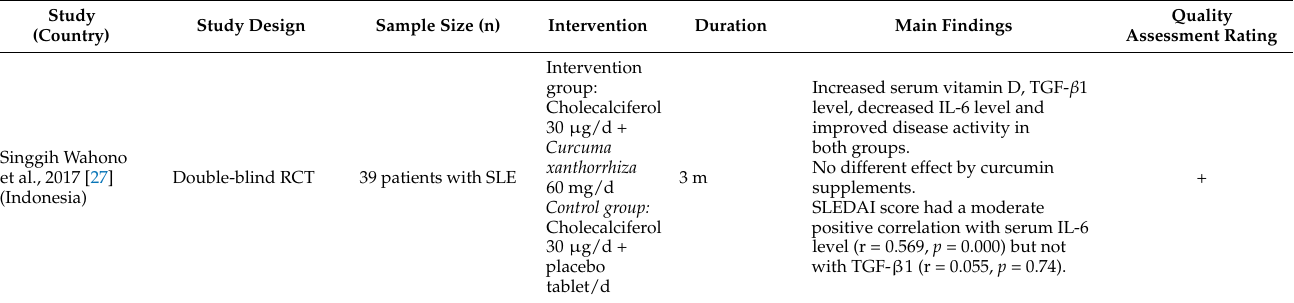
Table 4. Characteristics of included studies on curcumin supplementation interventions.